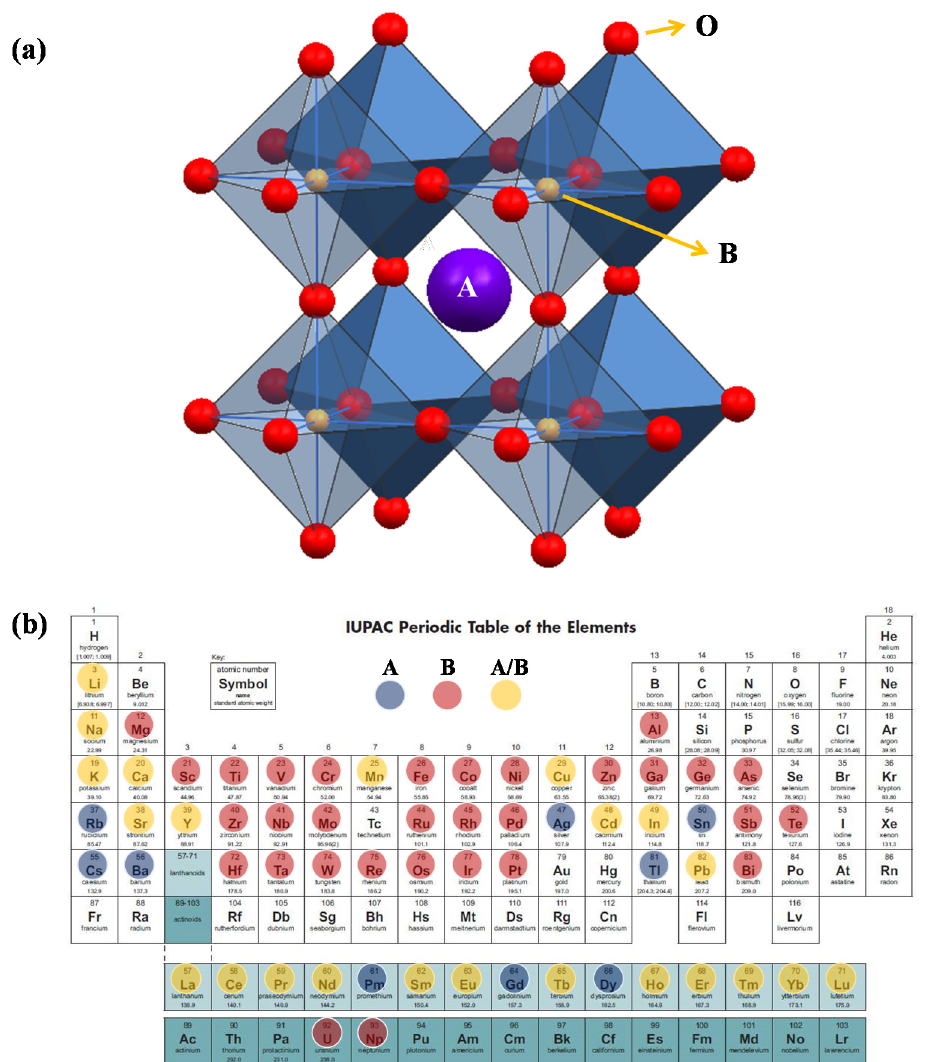
Figure 3. ( a ) Schematic illustration of an ideal perovskite oxide unit cell. ( b ) The elements that appeared on the A- or B-site in perovskite oxides available in the experimental data. The blue label represents the A-site, the red label represents the B-site, and the yellow label represents either the A- or B-site.